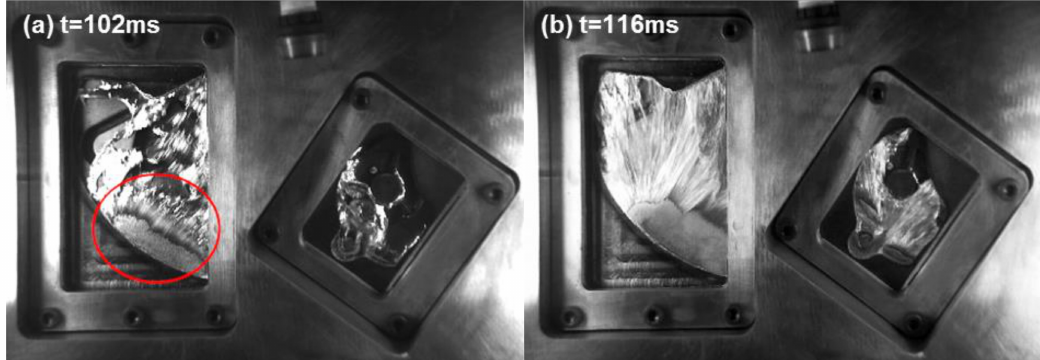
Figure 4. The actual filling process within the transparent windows (the time shown in ( a , b ) is the same as Figure